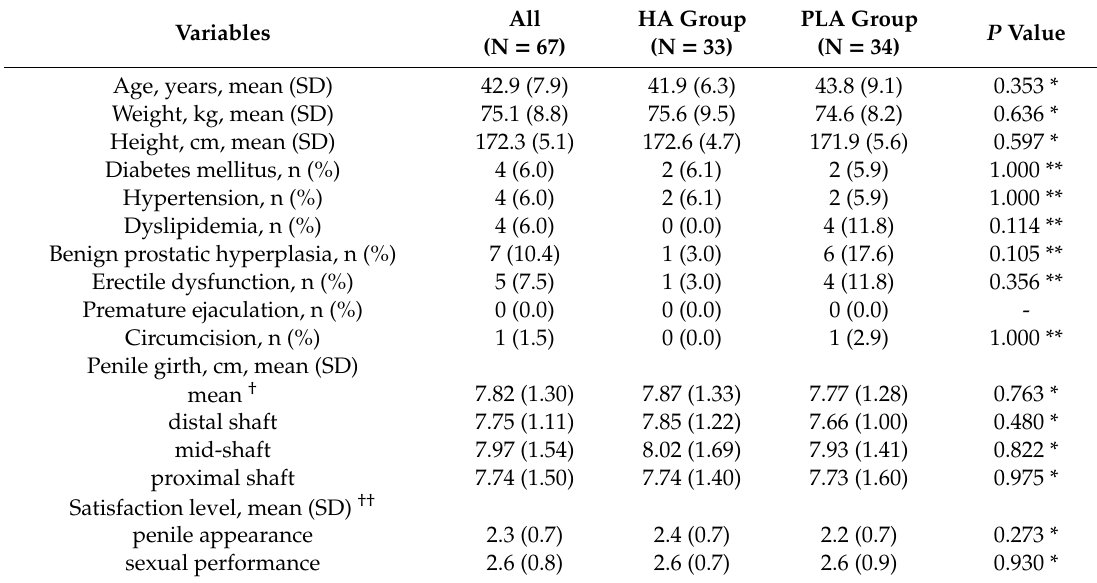
Table 1. Baseline demographic and clinical